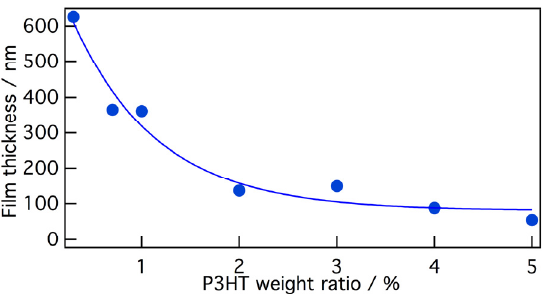
Figure 3. The average film thickness as a function of P3HT/PMMA composition.